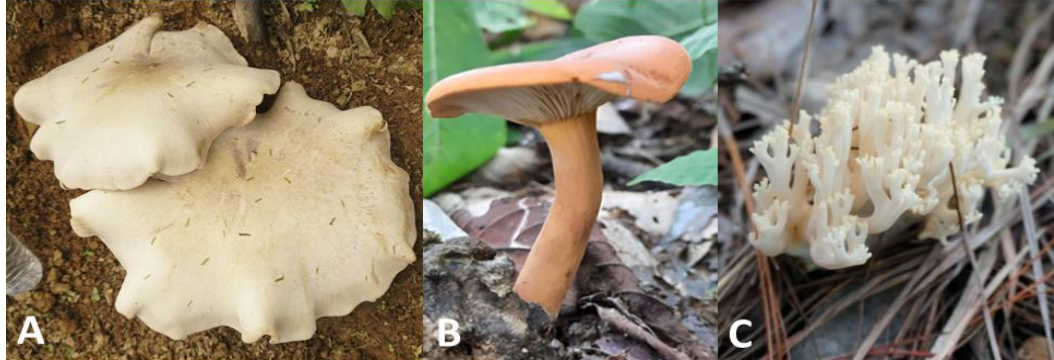
Figure 1. Fruiting body of the wild edible mushrooms in this study. ( A ) Macrocybe gigantea J124; ( B ) Lactifluus leptomerus J201; ( C ) Ramaria thindii J470.